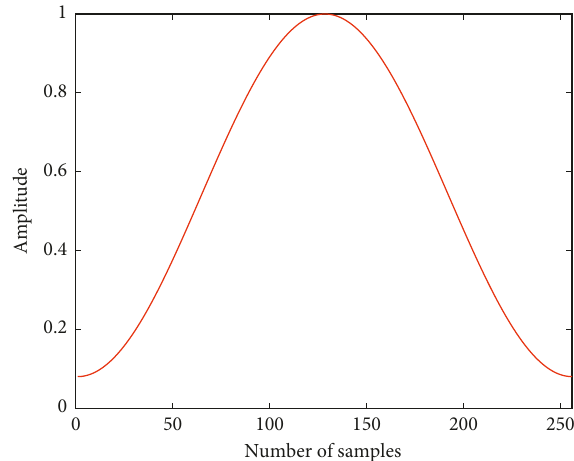
Figure 7: Hamming